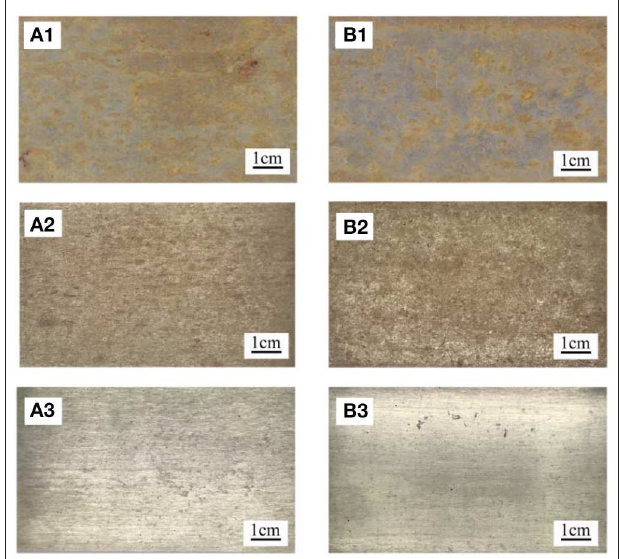
FIGURE 3 | Macroscopic corrosion morphology of each sample (A1–A3) Bare samples exposure for 1 year, exposure for 5 years, and after rust removal of 5 years. (B1–B3) pre-passivated samples exposure for 1 year, exposure for 5 years, and after rust removal of 5 years exposure.